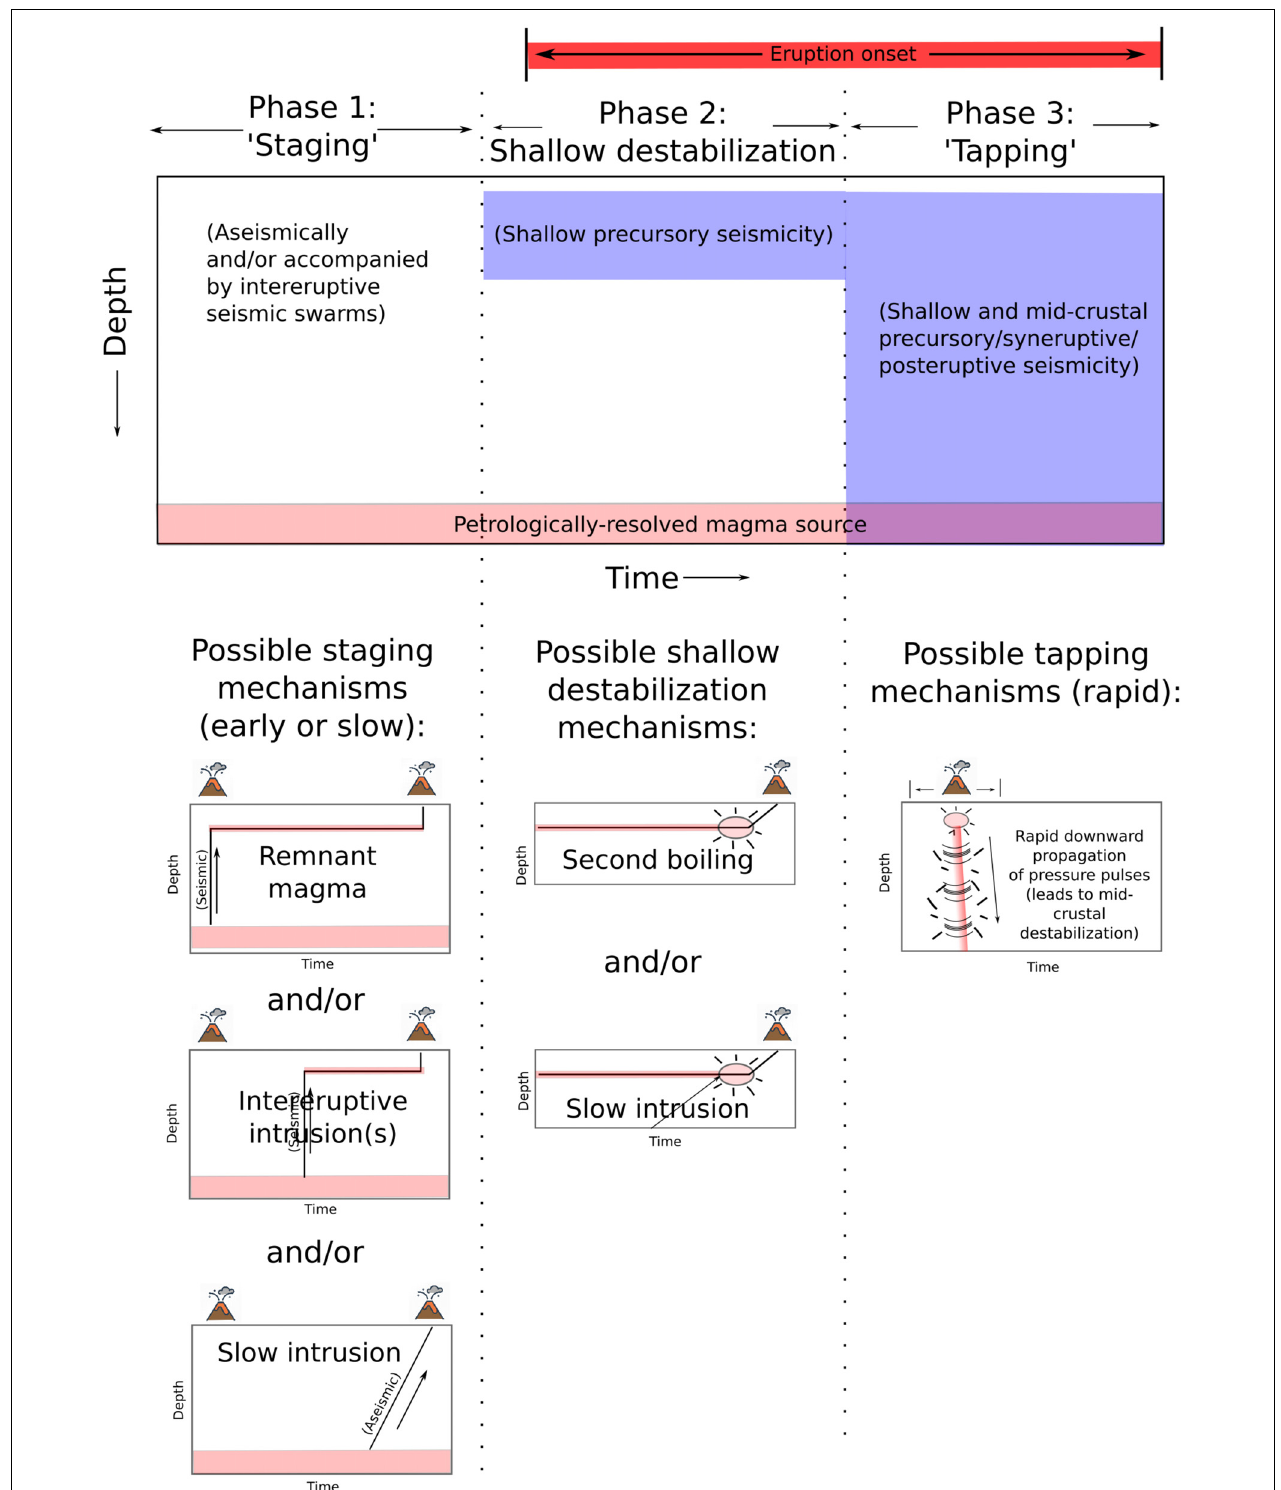
FIGURE 9 | Cartoon illustrating a proposed three-phase model for magma ascent and eruption. Top panel shows a schematic time-depth plot illustrating observed patterns of seismicity relative to the magma source, which define three phases of magmatic activity. Bottom panel shows possible mechanisms for each phase, which are not mutually exclusive and can act alone or in combination. The upper red bar indicates the time window during which eruption may begin (i.e., eruption may start any time after the onset of Phase 2).